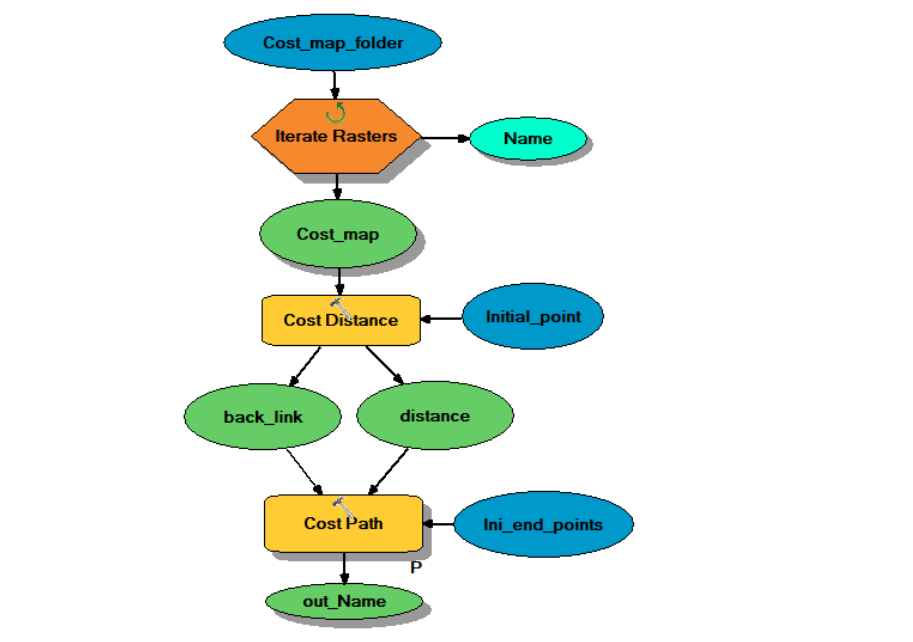
Figure A2. Flow diagram from the ArcGIS toolbox Model builder.